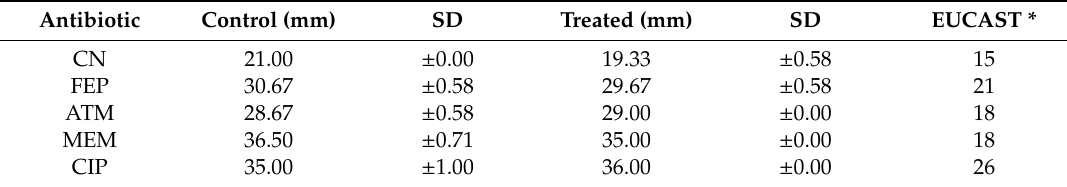
Table 1. Antibiotic susceptibility on treated and control